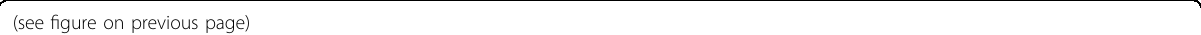
Fig. 2 NAC treatment improved pulmonary cell senescence, DNA damage, and SASP in Bmi-1 − / − mice more than in Bmi-1 − / − p16 − / − mice. a Representative micrographs of paraf fi n-embedded pulmonary sections stained for senescence-associated β -galactosidase (SA- β -gal), stained immunohistochemically for p53, 8-hydroxyguanosine (8-OHdG), IL-1 β , IL-6, and TNF- α , and stained immuno fl uorescently for CD3 and F4/80. SA- β -gal-, p53-, 8-OHdG-, CD3-, or F4/80-positive cells are indicated by arrows. b Percentage of cells positive for SA- β -gal, p53, 8-OHdG, CD3, F4/80, IL-1 β , IL-6, and TNF- α or with positive area relative to the total cells or area. c Bmi-1 , p16 , IL-1a , IL-1 β , IL-6 , and TNF- α mRNA levels in lungs by real-time RT-PCR, calculated as the ratio to β -actin mRNA and expressed relative to that of WT. d Western blots of pulmonary extracts showing p16, p19, p53, p21, and 8- OHdG. β -actin was used as the loading control. e Protein levels relative to β -actin were assessed by densitometric analysis. Six mice per group were used for experiments. Values are the mean ± SEM from six determinations per group. * P < 0.05, ** P < 0.01, *** P < 0.001 compared with the WT group; # P < 0.05, ## P < 0.01, ### P < 0.001 compared with the Bmi-1 − / − group; & P < 0.05, && P < 0.01, &&& P < 0.001 compared with the Bmi-1 − / − p16 − / −